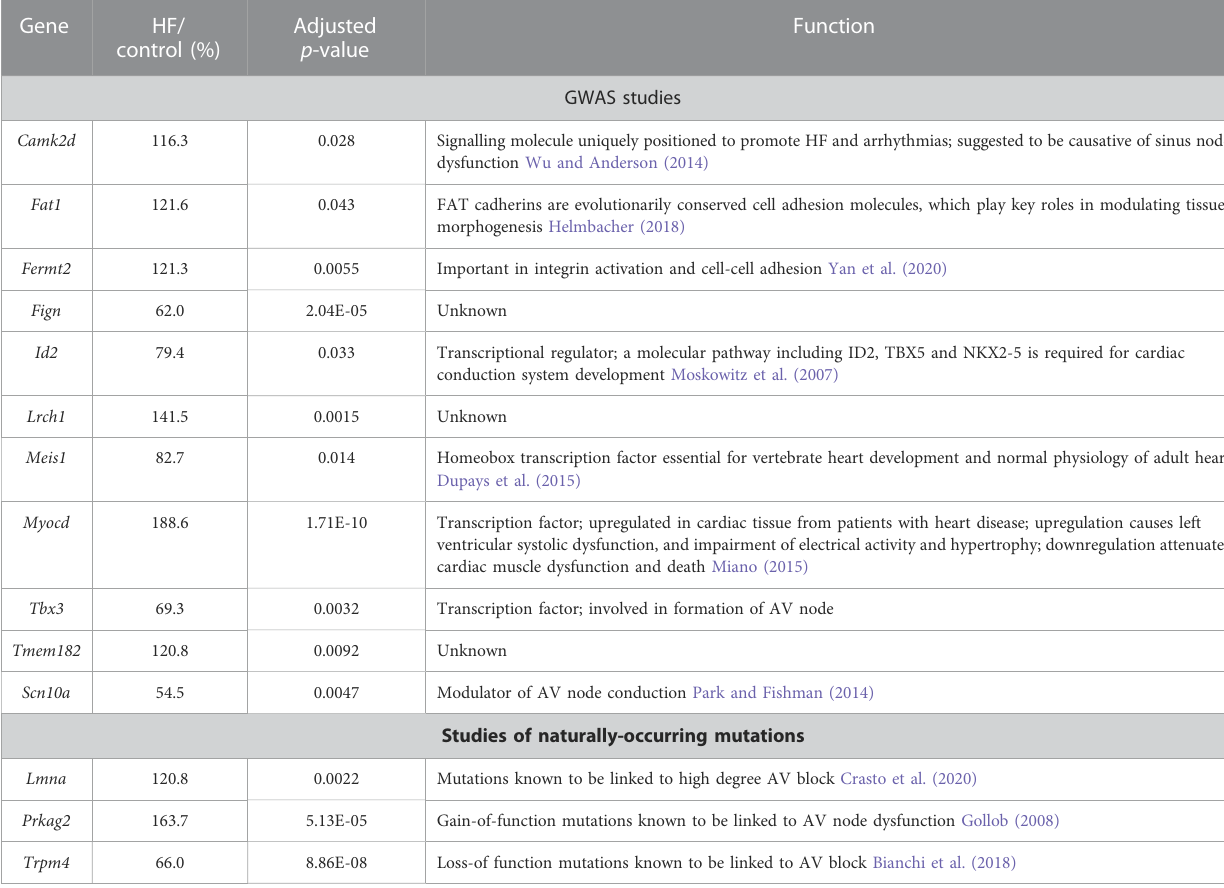
TABLE1Transcriptswhichchangedsigni fi cantlyintheAVnodeinHFandthecorrespondinggeneshavebeenidenti fi edbyGWASstudiesasbeingassociatedwith the PR interval or naturally-occurring mutations in the corresponding genes are associated with AV block. Gene/transcript name, transcript abundance in HF as a percentage of that in control animals, adjusted p -value of the change in HF, and notes on the functions of the genes